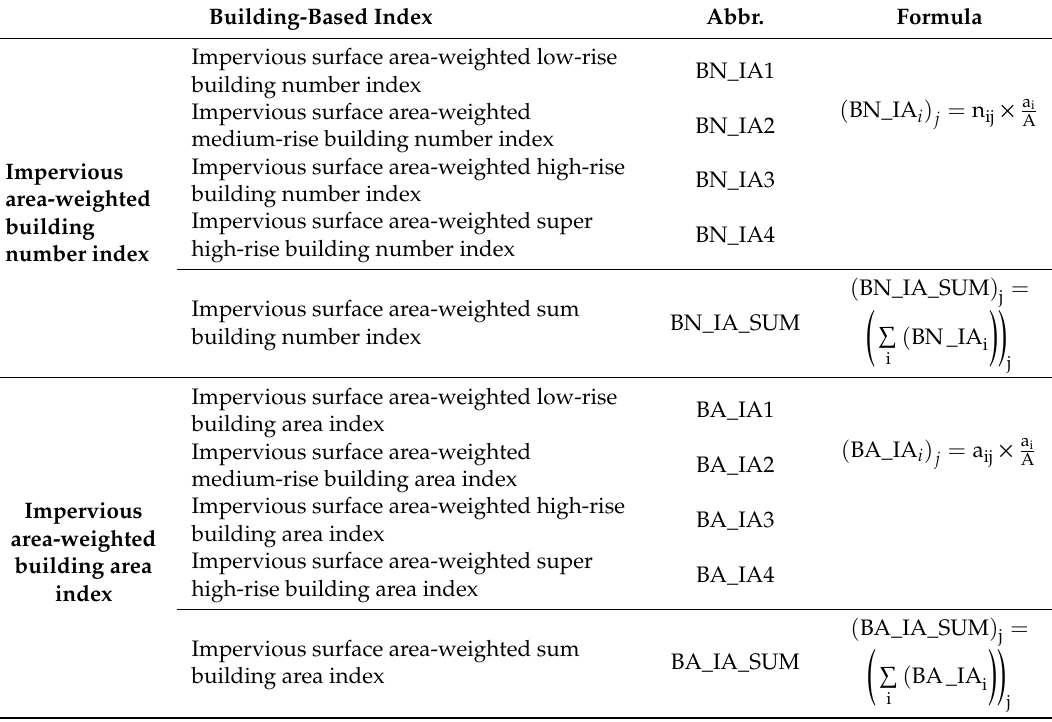
Table 3. Mathematical details of the enhanced building-based